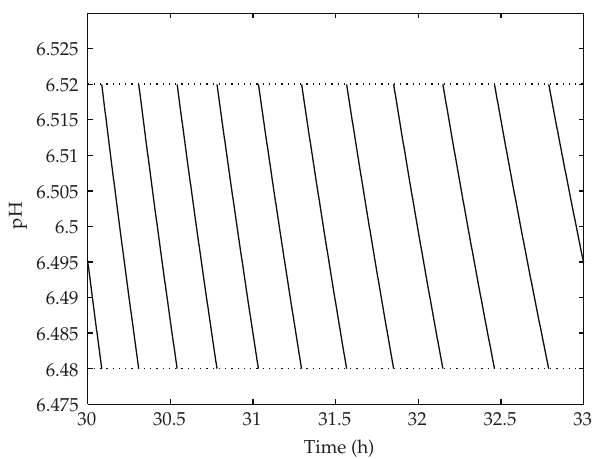
Figure 10: Simulation of the pH during 30–33 hours of fed-batch